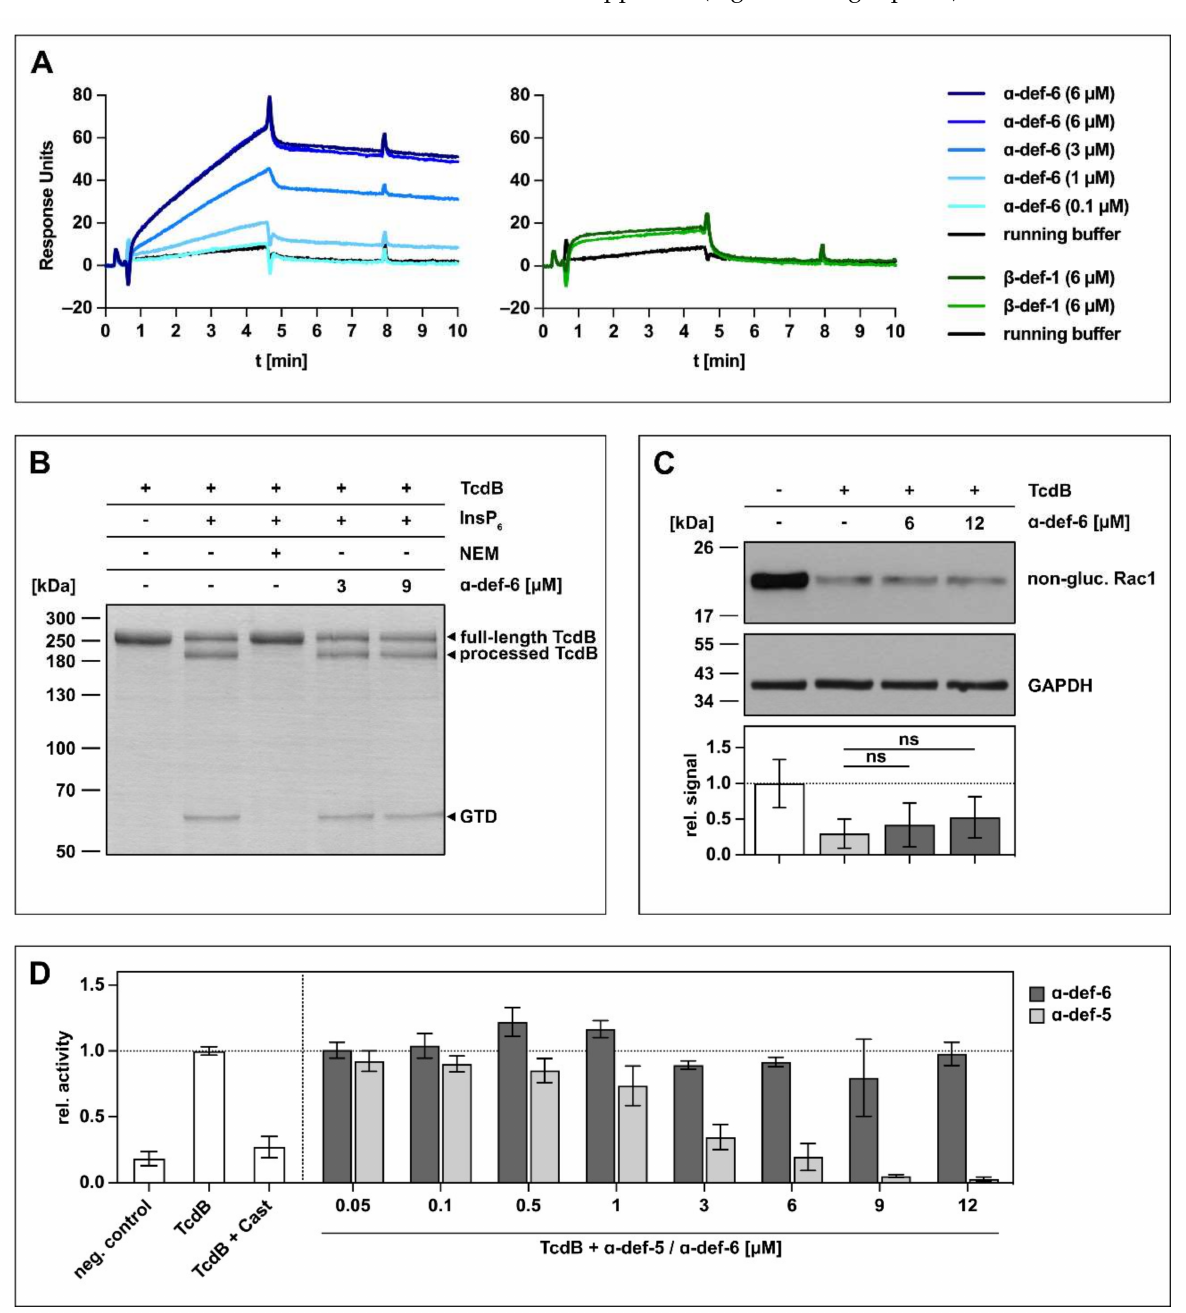
Figure 1. α -def-6 directly binds to TcdB in vitro but does not affect the autoproteolytic- and glucosyl- transferase activity of TcdB. ( A ) 2400 RUs of biotinylated TcdB were immobilized via